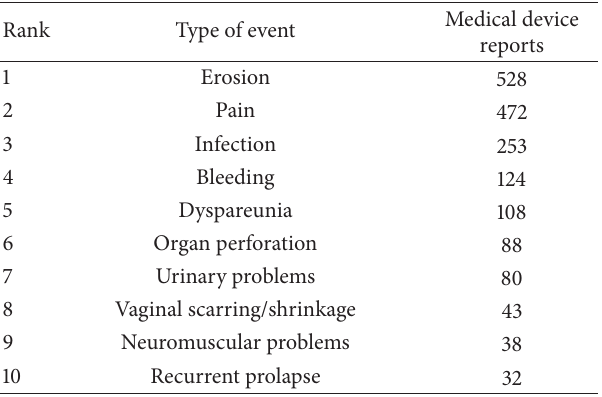
Table 1: Reported mesh augmented pelvic organ prolapse surgery adverse events (MAUDE database),